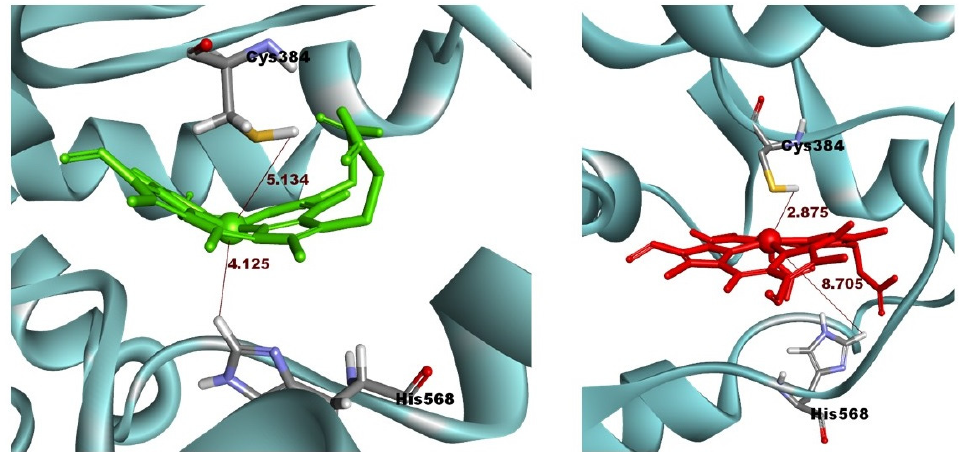
Figure 10. The distance between Cysteine 384 and Histidine 568 on the Agonist-REV-ERB β and the metal central atom of Heme (green) and CoPP (red) during molecular dynamic simulations.